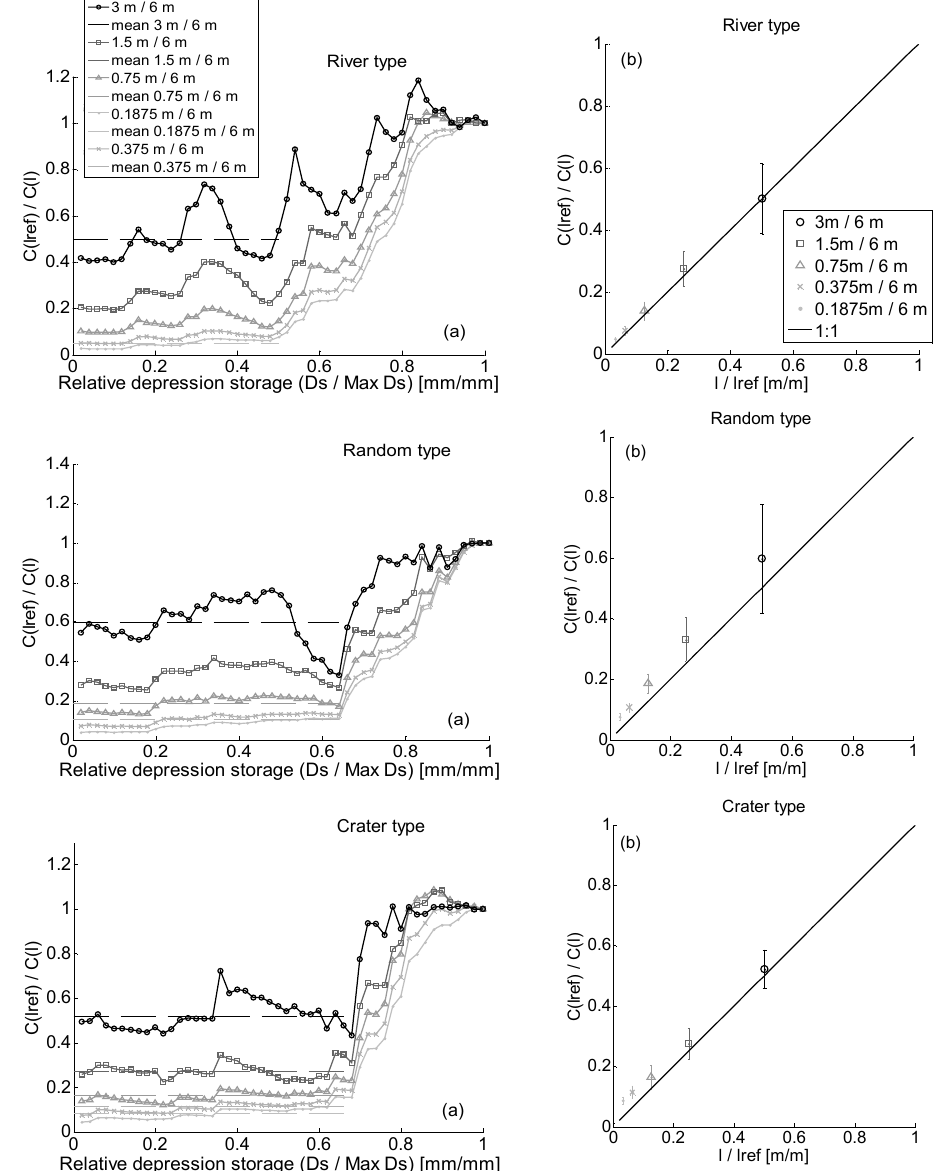
Fig. 16. Synthetic fields – scale effect when changing the length for the river, random and crater microtopographies: (a) ratio of connectivities at different scales as a function of the relative depression storage. Horizontal dashed lines correspond to the mean value of the connectivity ratio calculated over the range RDS=0 to RDS=0.5–0.7. (b) Correlation between the scale ratios and the ratios of connectivities for the first two thirds of the RSC function. Vertical lines=standard deviation. All the plots are 6m